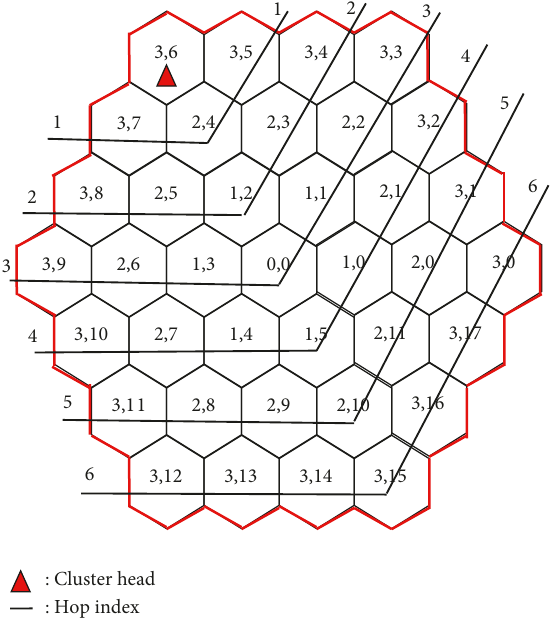
Figure 6: Hop index of the cells in the honeycomb The hop index of the cells will change after every round according to the new CH cell direction, and the nodes from all cells forward the sensed data to this new CH cell. Algorithm 2 returns the hop index ( L ) of every cell in the cluster by comparing its address with the address of the CH cell.